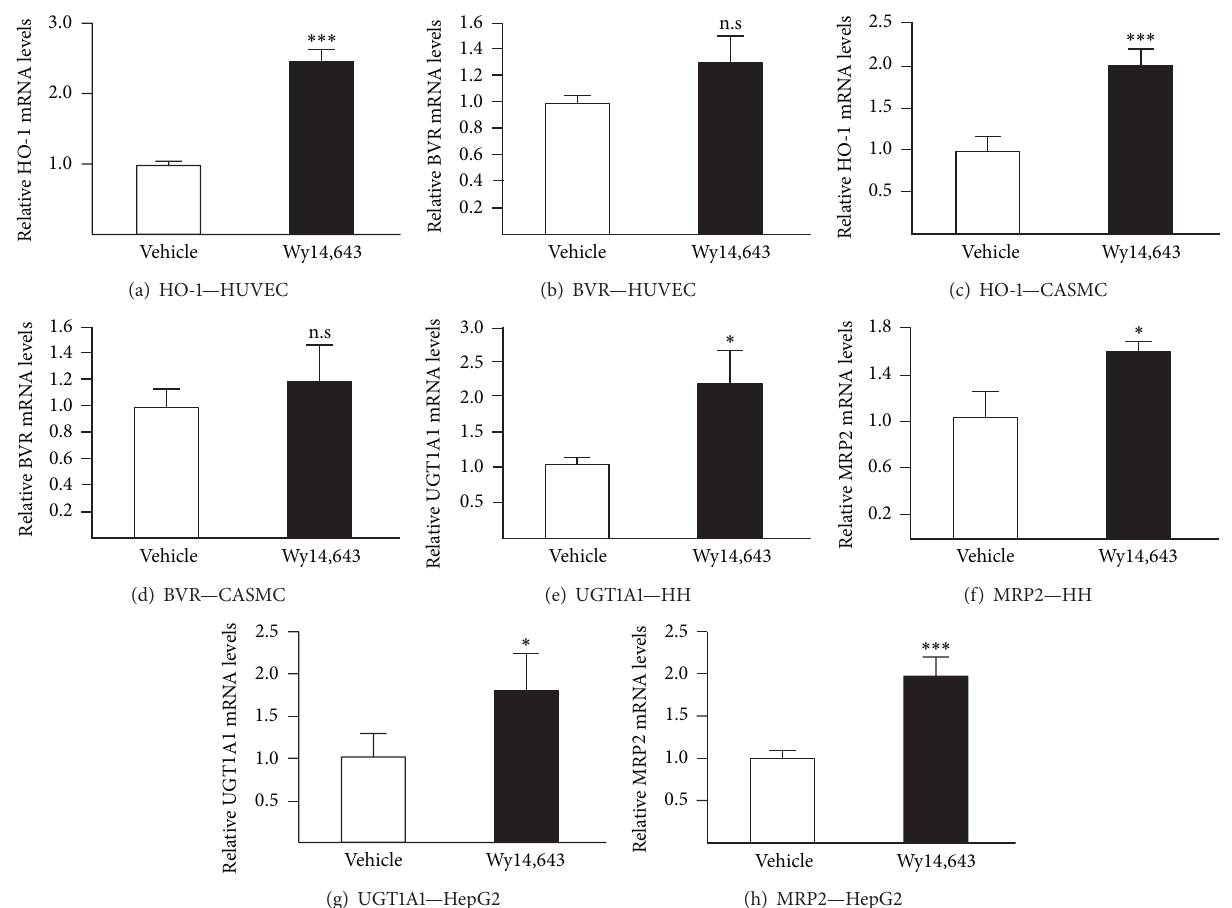
Figure 3: The high affinity PPAR 𝛼 agonist Wy14,643 increases HO-1, UGT1A1, and MRP2 mRNA levels in human vascular and hepatic cell models. Human umbilical vein endothelial cells (HUVEC) (a and b), coronary artery smooth muscle cells (CASMC) (c and d), human hepatocytes (HH; donor 1) (e and f), and HepG2 cells (g and h) were treated with vehicle (DMSO, 0.1%, v/v) or Wy14,643 (75 𝜇 M) for 24 H. HO-1, BVR, UGT1A1, and MRP2 mRNA levels were quantified from total RNA through quantitative RT-PCR analyses and normalized with thehousekeepingRNA28S.Values(mean ± SD)areexpressedrelativelytocontrol(vehicle)setat1.Statisticallysignificantdifferencesbetween vehicle- and Wy14,643-treated cells are indicated by asterisks (Student’s 𝑡 -test: ∗ 𝑃 < 0.05 ; ∗∗∗ 𝑃 < 0.001 ; n.s: